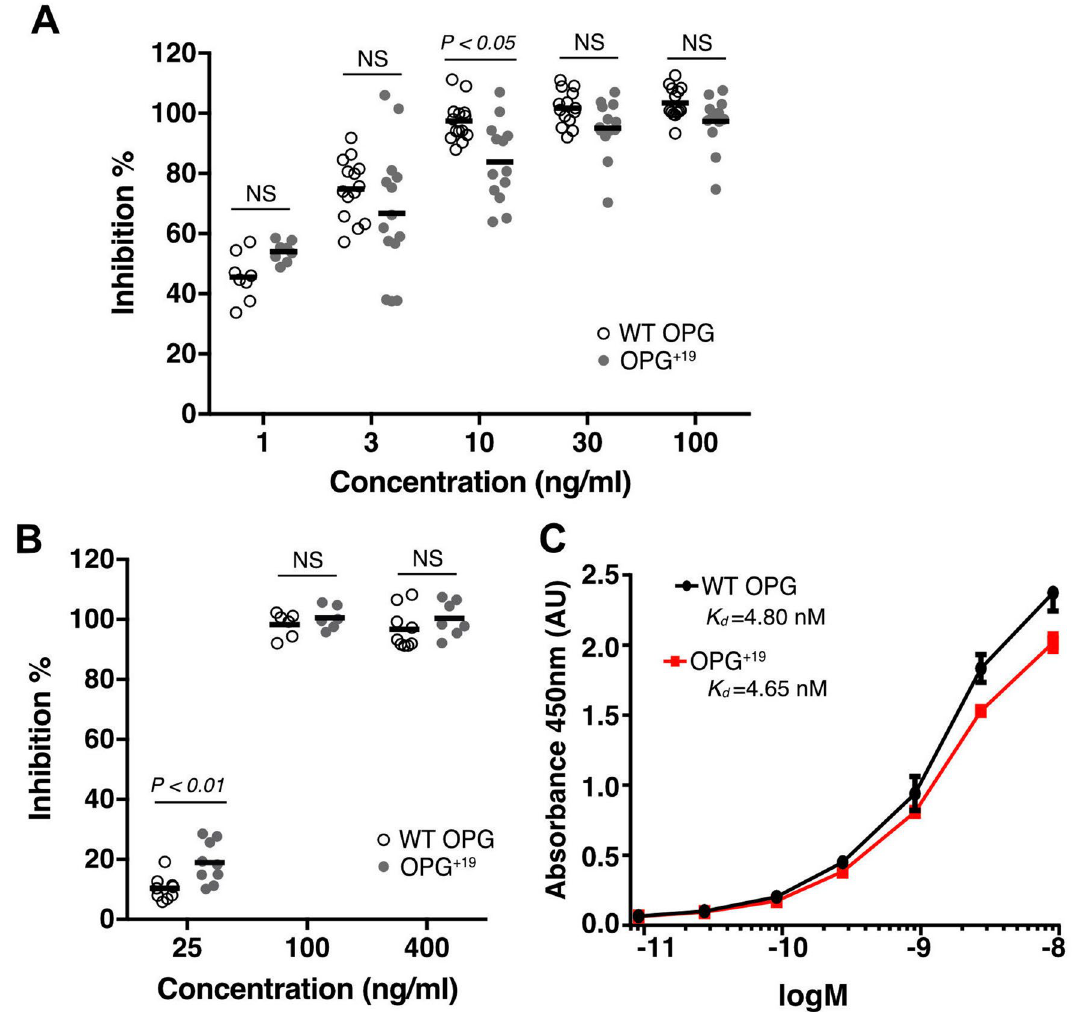
cell lysate. ( B ) Inhibition of osteoclastogenesis in bone marrow macrophage monoculture by WT hOPG or mutant hOPG at 25, 100 and 400 ng/ml. Osteoclastogenesis is induced by recombinant soluble RANKL (50 ng/ ml) and M-CSF (20 ng/ml). ( C ) Binding affinity of WT hOPG and mutant hOPG to immobilized RANKL was determined by enzyme-linked immunosorbent assay